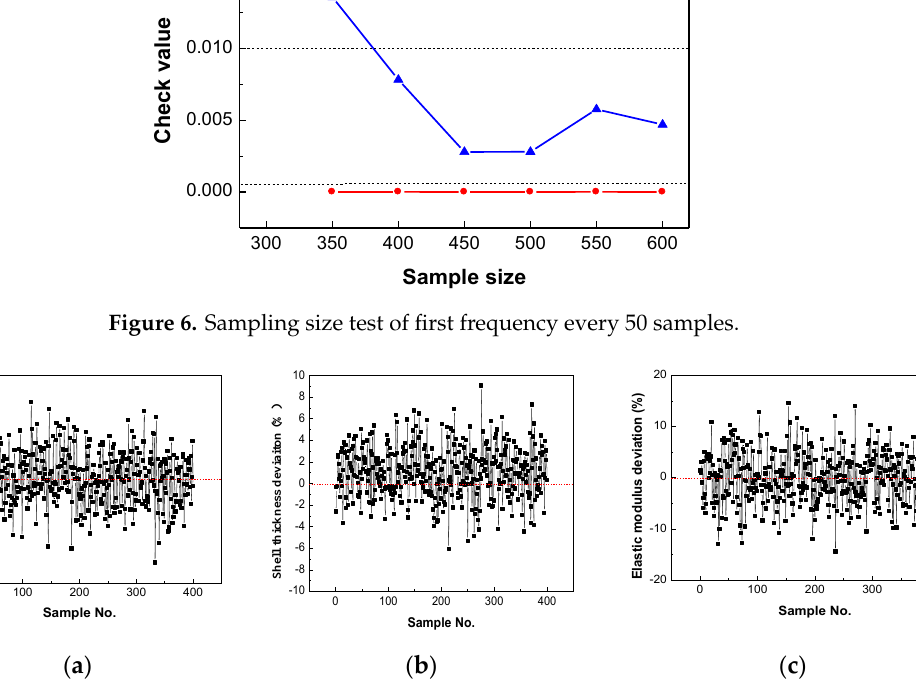
Figure 7. Samples of uncertainty parameters with size of 400: ( a ) Initial geometric imperfection; ( b ) Shell thickness deviation; and, ( c ) Elastic modulus deviation.